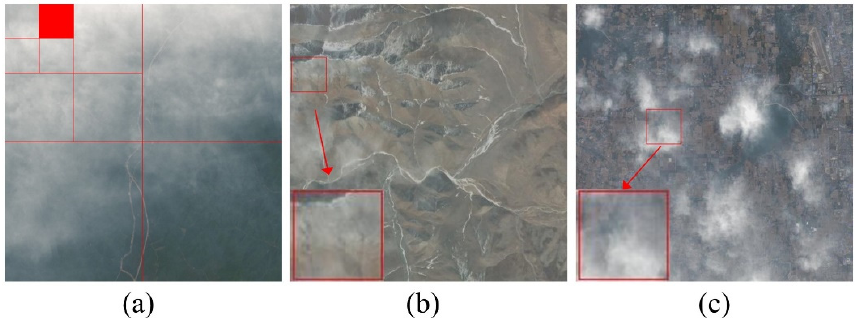
Figure 2. AL estimation by the quad-tree hierarchical search algorithm, where ( a ) illustrates the quad-tree subdivision procedure and ( b ) and ( c ) show the close-up of the final selected blocks as the AL estimation.